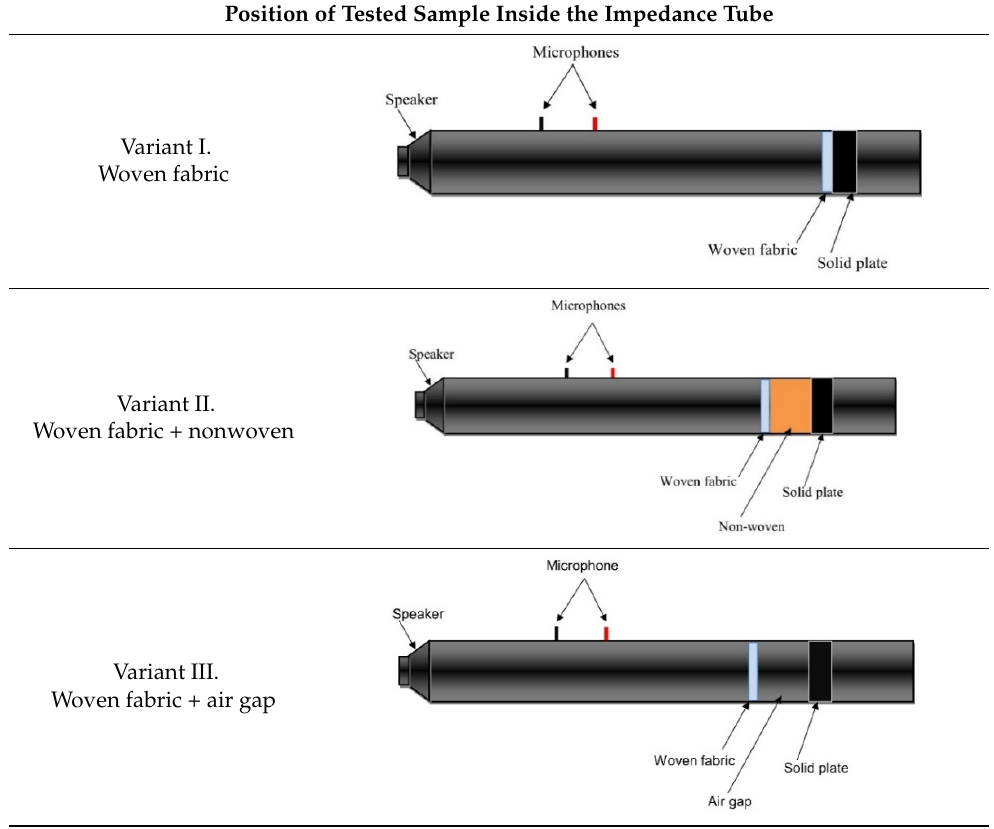
Table 3. Arrangement and setting of woven